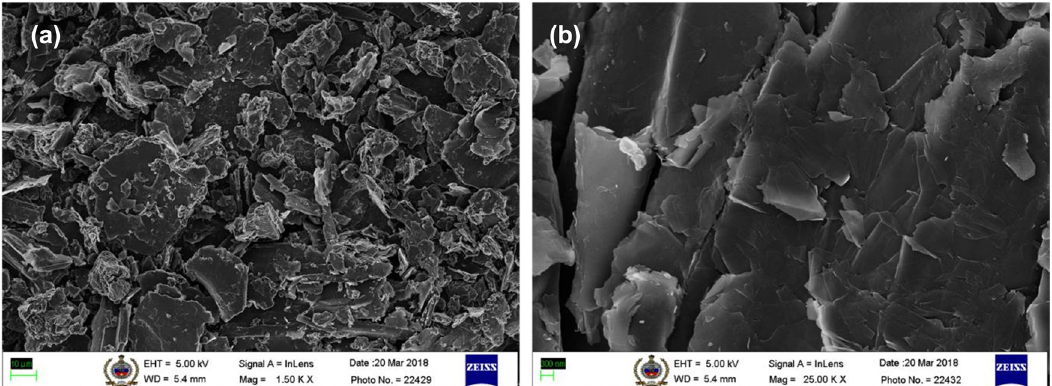
Figure 6: ( a ) and ( b ) SEM images of Gr powder at di ff erent magni fi cations.